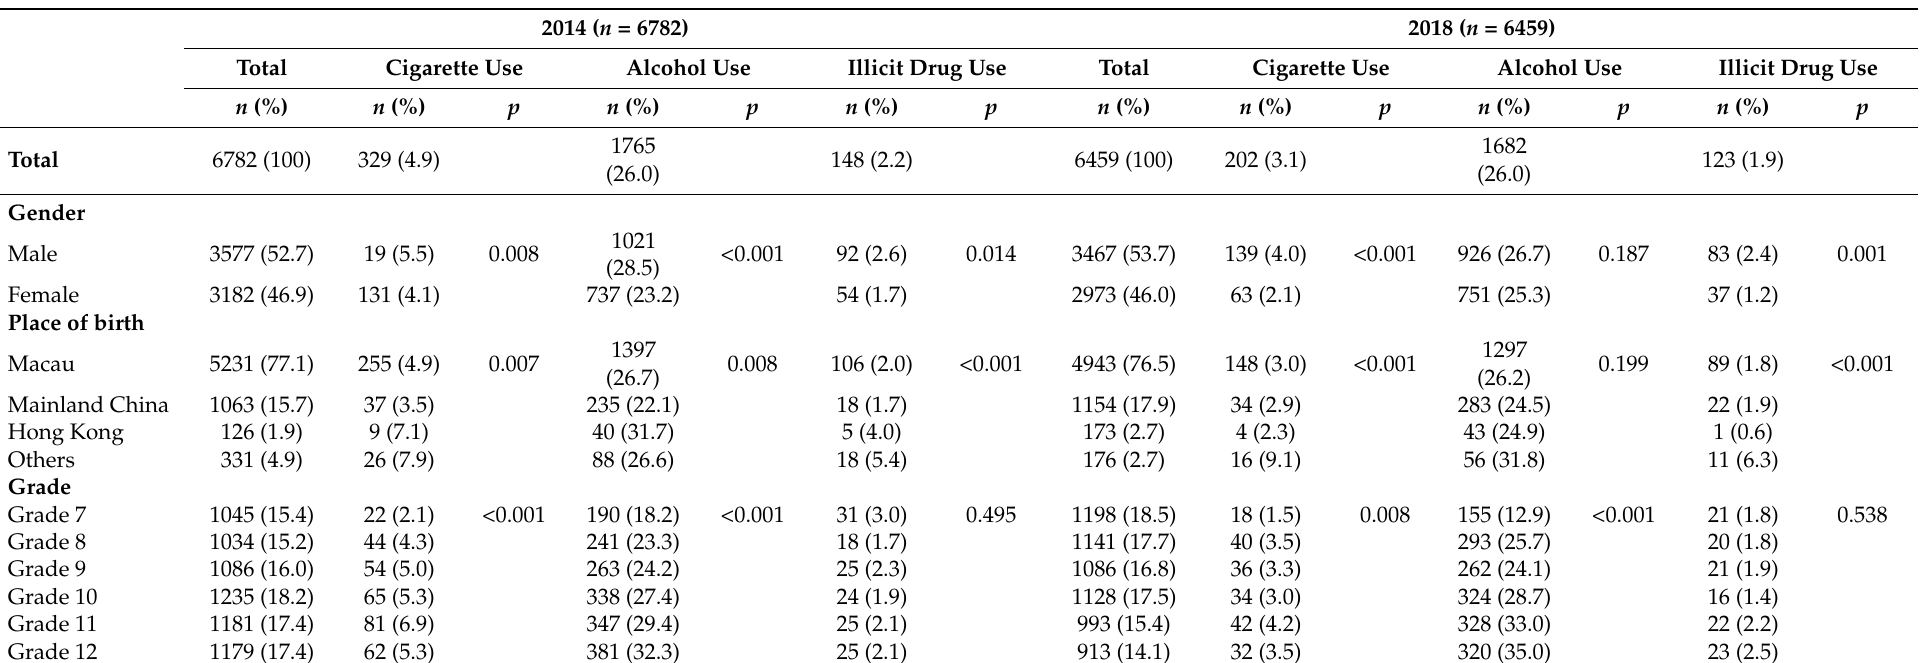
Table 1. Prevalence of past 30-day substance use among students from grade 7 to grade 12 in Macau in 2014 and